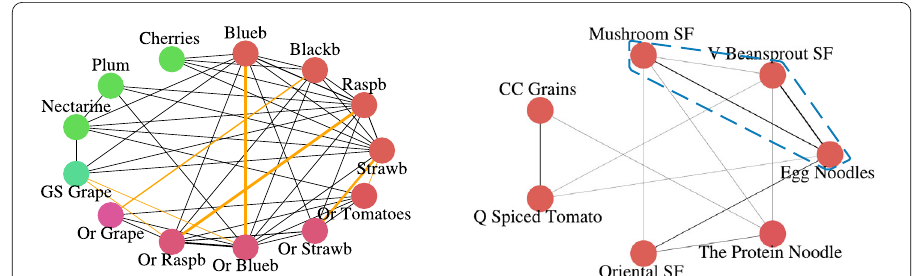
Figure 8 Internal structure of the complement roles of berries (3) ( left ) and of stir-fry (9) ( right ), with product nodes connected by both the complementarity scores ( W ( c ) ij ) (in black) and the substitutability scores ( W ( s ) ij ) (in orange), where the line thickness corresponds to how high the scores are, and products in the same L1 category are shown in the same colour